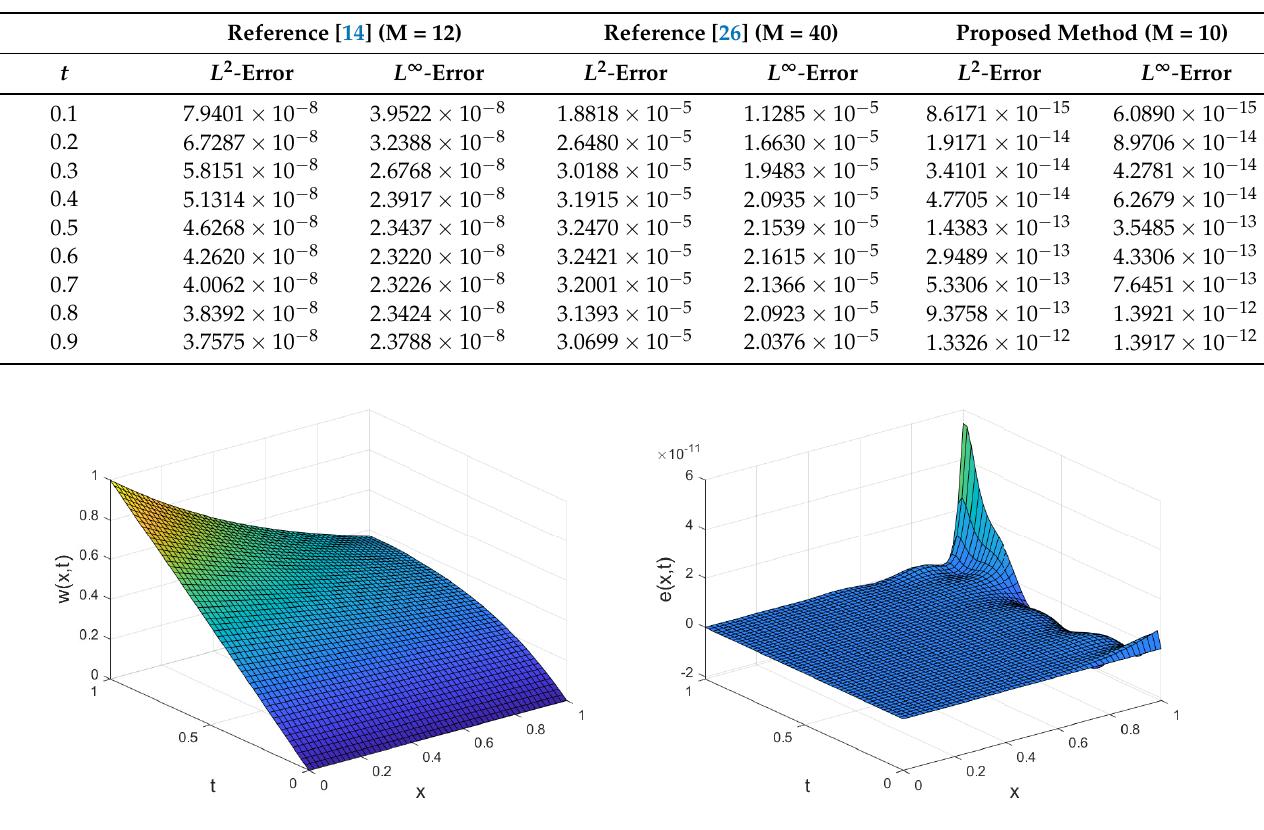
Figure 2. Plot of the approximate solution and absolute value of the error for Example